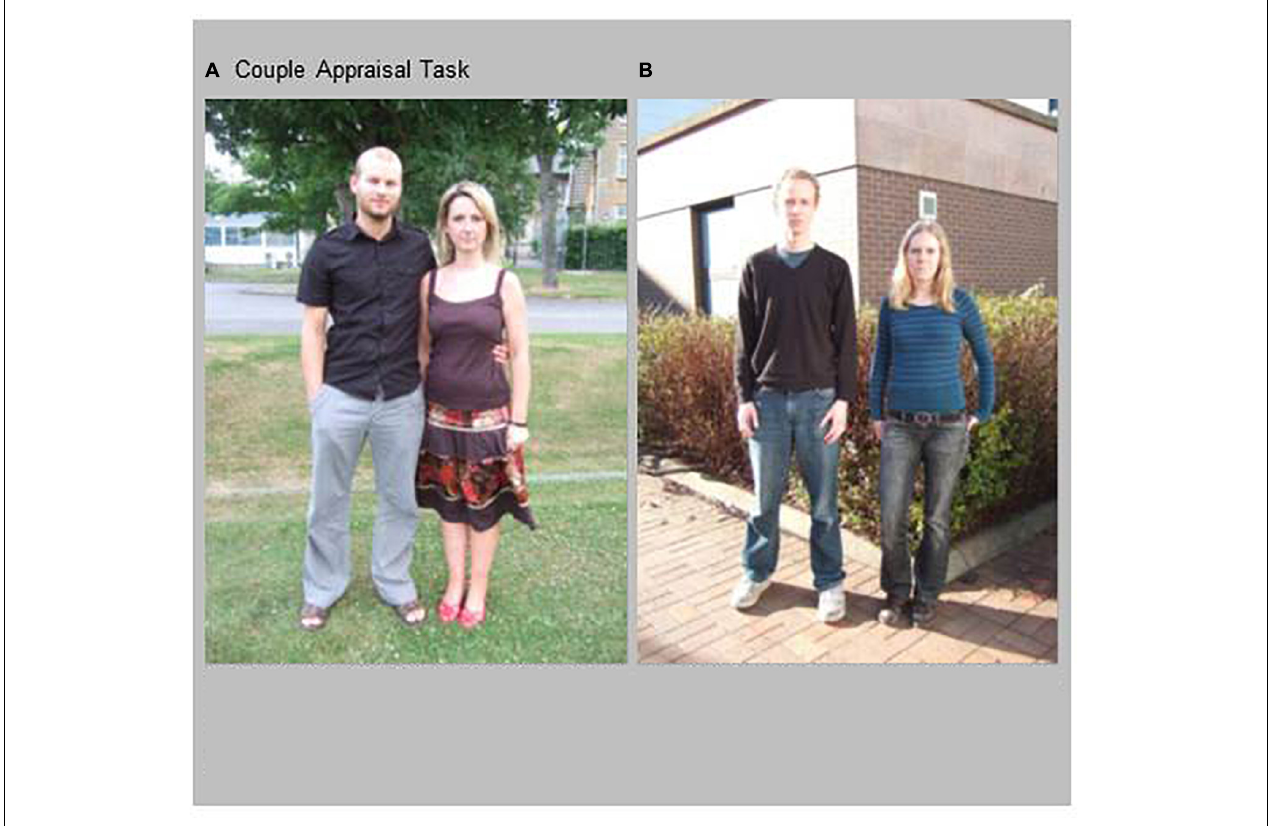
FIGURE 2 | CAT Examples. Couples (A) with body contact, (B) without body contact. Written informed consent was obtained from these individuals for the publication of the two